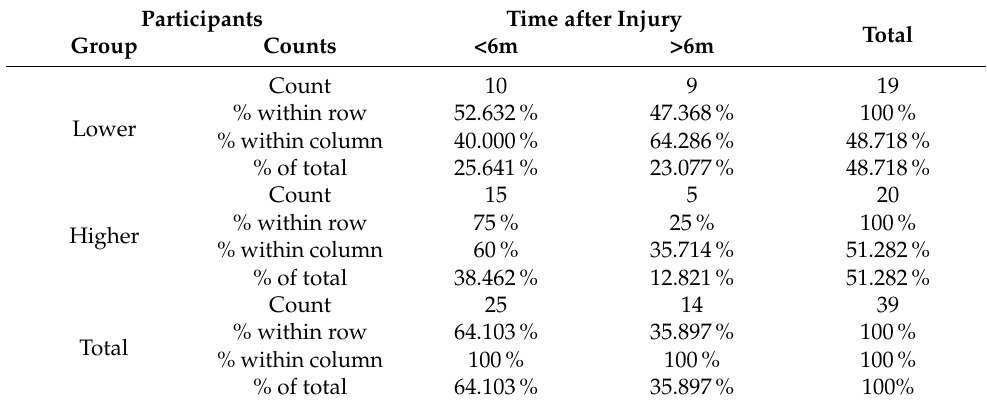
Table 3. Contingency tables across evocation groups and early and late post-stroke